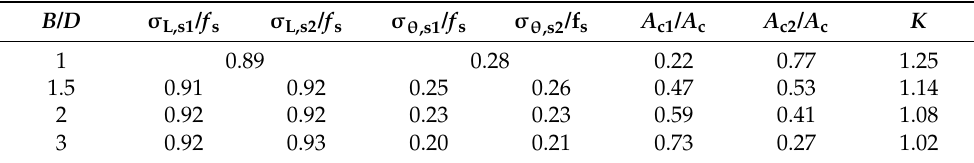
Table 3. Relationships between the axial stress, transverse stress, and yield strength of steel